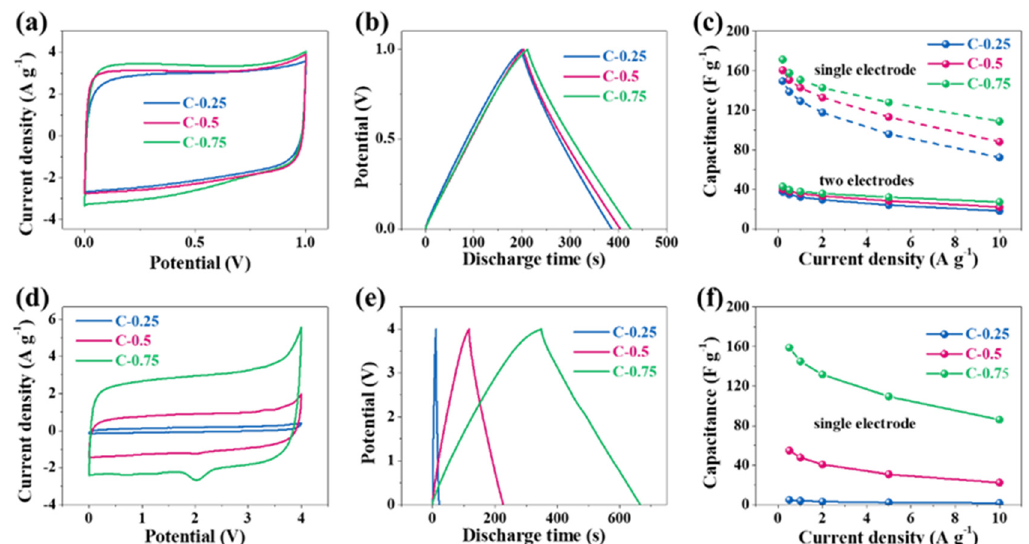
Figure 5. Electrochemical performance of the two-electrode symmetric supercapacitor in ( a – c ) 6 M KOH electrolyte and ( d – f ) EMIBF 4 ionic liquid electrolytes (ILs). ( a , d ) Cyclic voltammetry (CV) curves conducted at 20 mV s − 1 , ( b , e ) galvanostatic charge–discharge (GCD) curves conducted at 0.5 A g − 1 , and ( c , f ) rate capability ranging from 0.5 to 10 A g − 1 for three samples with various pore size distribution (PSDs) and doping levels.